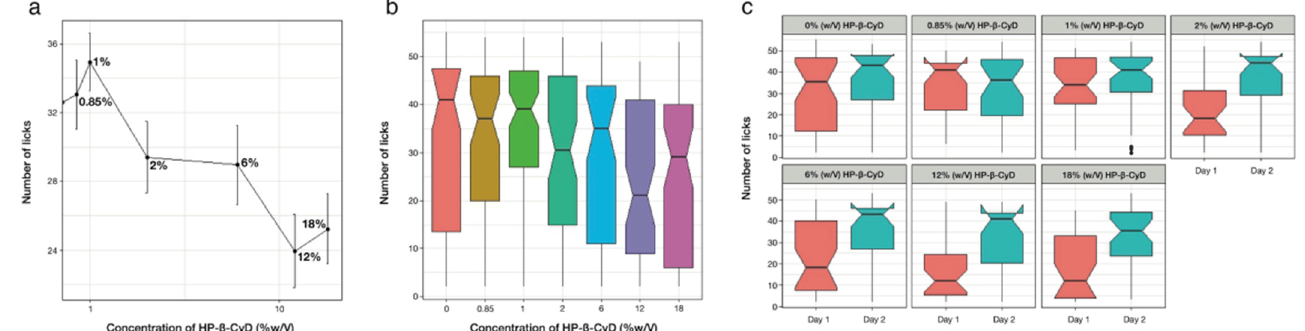
Figure 5. ( a ) Average number of licks ( ± SEM) as a function of HP- β -CyD concentration (% w / v ) with 1 mg/mL SPL; ( b ) boxplots representing the number licks as a function of HP- β -CyD concentration (% w / v ) with 1 mg/mL SPL; ( c ) boxplots representing the number of licks recorded as a function of HP- β -CyD concentration (% w / v ) with 1 mg/mL SPL between testing day 1 (red) and testing day 2 (blue).